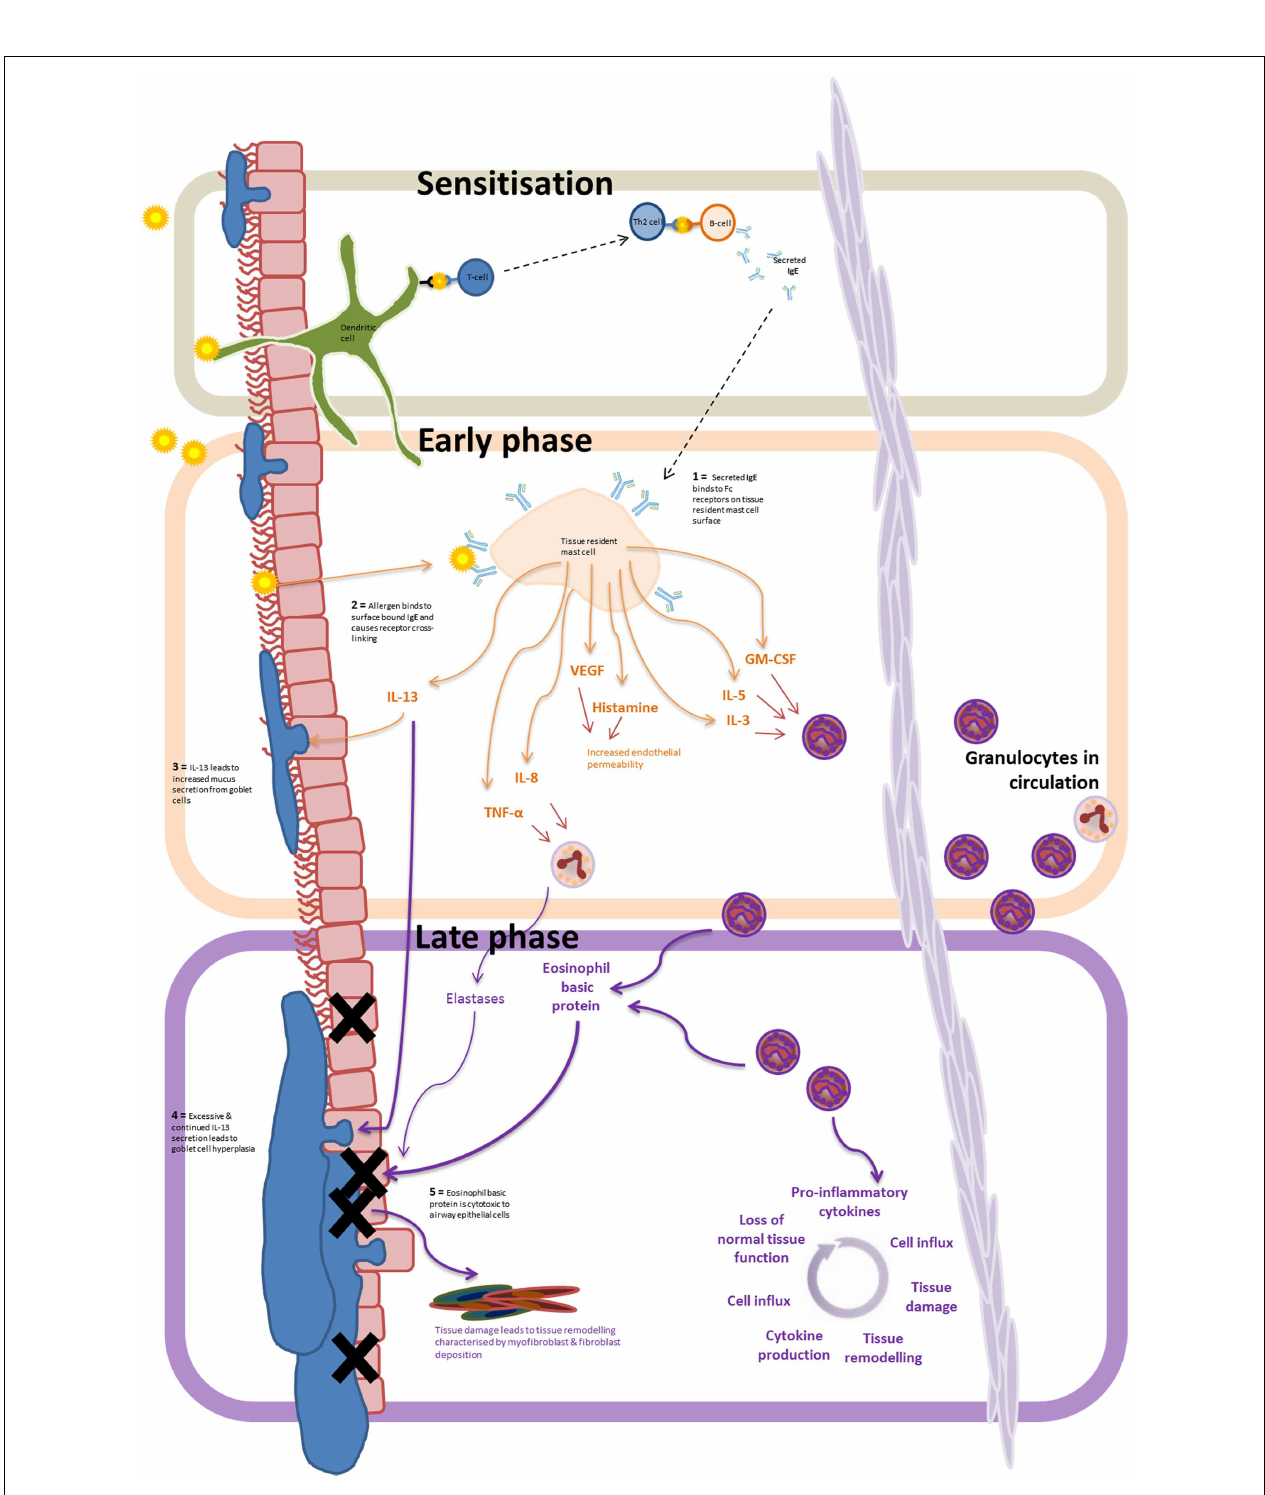
VEGFA from mast cells results in eosinophil recruitment, increased vascular permeability, and increased mucus secretion by goblet cells. Continued exposure to the allergen, and infiltration of granulocytes to the inflamed tissue marks the progression to the late phase of the inflammatory response. Prolonged secretion of IL-13 and the release of intracellular cytotoxic granules by recruited eosinophils (and neutrophils) lead to continual tissue damage, mucus hypersecretion, and tissue remodeling resulting in the gradual loss of normal lung